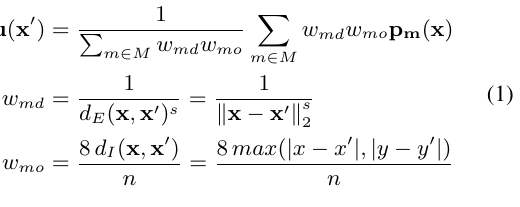
For IDW interpolation along a specific path over the input, the run sequence archetype is followed starting at the respective im- age boundary according to the sweep scheme. Each run pixel at image position x (cid:48) gets tested for the nodata value assigned to the bitmap. If the pixel content is valid, its position x = x (cid:48) is backed up forming the last support pixel p m ( x ) on the path.